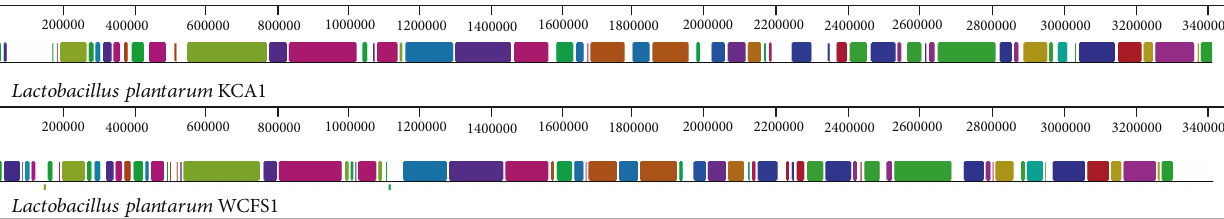
Figure 4: Genome comparison between L. plantarum WCFS1 and L. pentosus KCA1. The colored blocks correspond to LCBs.